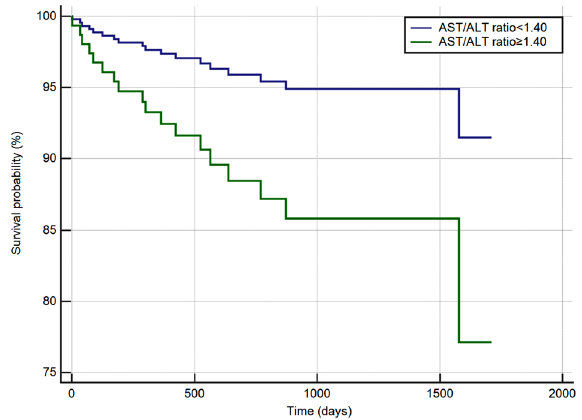
Figure 6. Multivariate Cox proportional hazard regression analysis of aspartate amino transferase (AST)/ alanine aminotransferase (ALT) ratio and all-cause